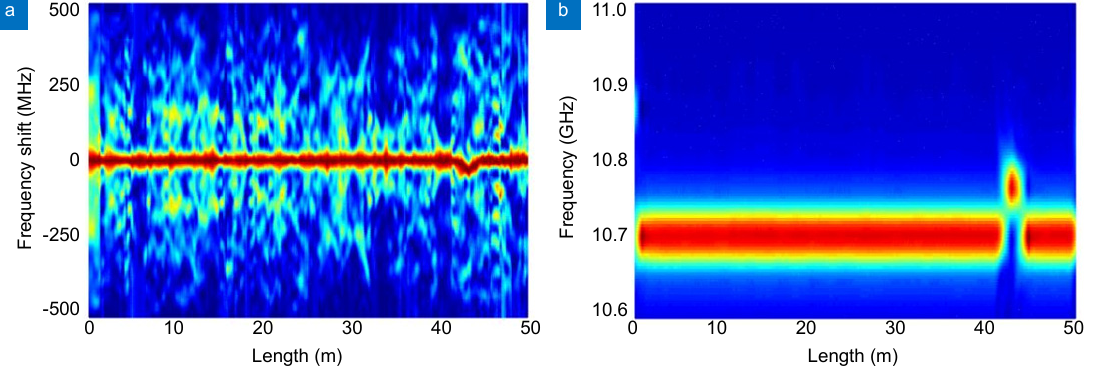
Fig. 5 | ( a ) The cross-correlation between Rayleigh spectra along the FUT containing the relative sub-micro strain information. ( b ) The meas- ured 3-D BGSs along the FUT, showing the pre-applied strain